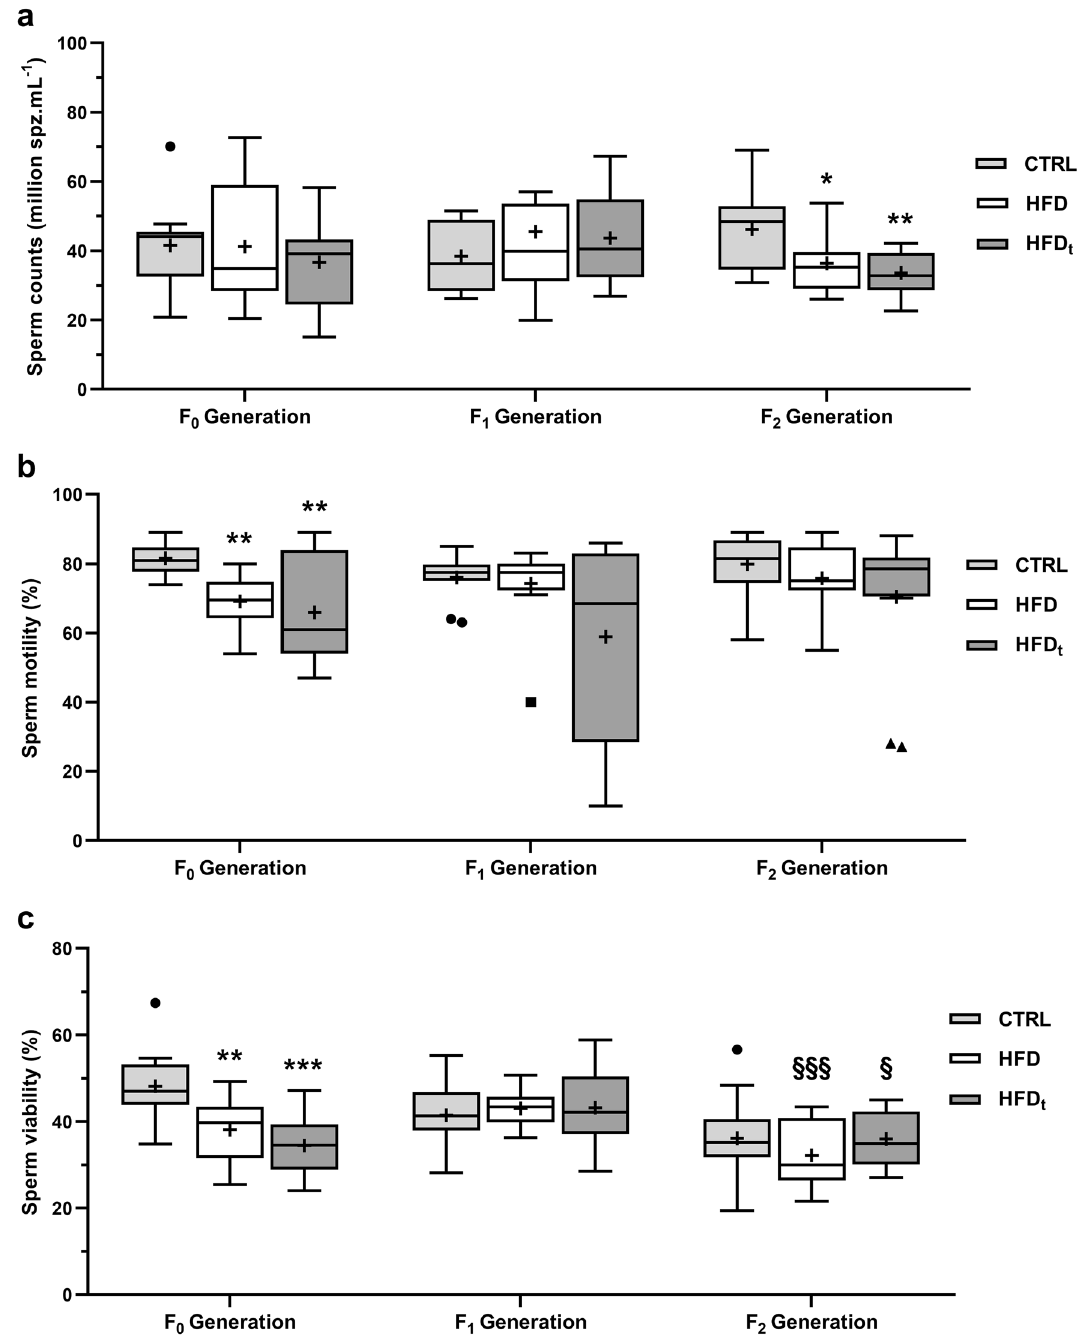
Figure 3. Sperm parameters across all the generations (n = 12 per group in each generation). ( a ) Sperm concentration; ( b ) sperm motility; ( c ) sperm viability. Results are expressed as Tukey’s whisker boxes (median, 25th to 75th percentiles ± 1.5 interquartile range). Extreme values are represented individually according to the experimental group (filled circle CTRL—standard chow; filled square HFD—high-fat diet; filled triangle HFD t —transient high-fat diet). Epidydimal sperm was obtained from mice immediately after sacrifice, at 200 days post-weaning. Data was tested by one-way ANOVA with Tukey’s HSD for group comparison within the same generation. Two-way ANOVA with Šidak correction was used to compare each diet group in F 1 Generation against its F 2 counterparts. Graphs were obtained using the software GraphPad Prism 8 (San Diego, CA, USA). Significance was considered when p < 0.05. * vs. CTRL; # vs. HFD; § vs. F 1 Generation. Multiple significance signs represent different significance levels: *p < 0.05; **p < 0.01; ***p < 0.001; ****p < 0.0001. + Group